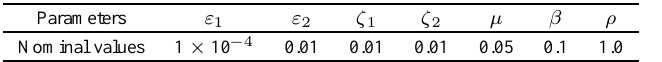
Table 1 Nominal values of the design